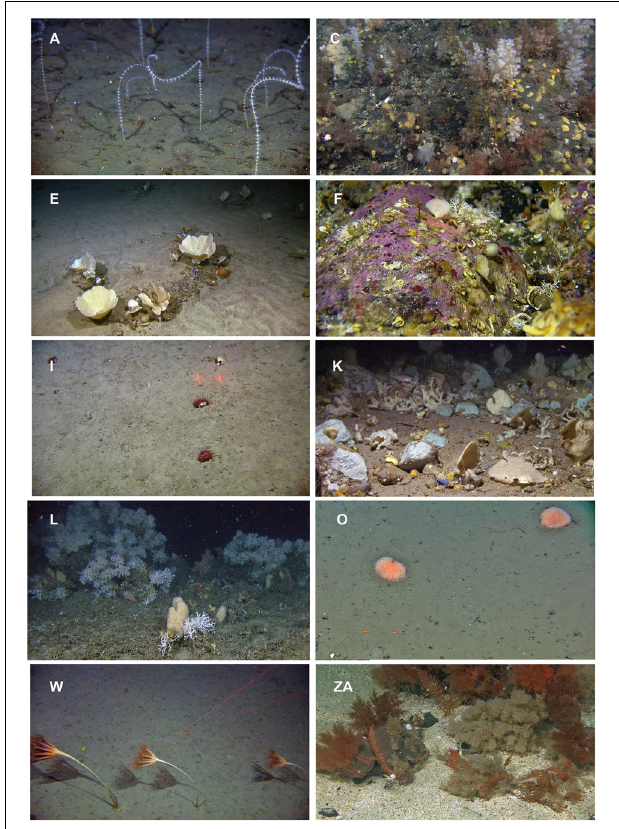
FIGURE 6 | Examples of 10 contrasting biotopes identified by a TWINSPAN analysis of the species data from the video analyses. The letters represent the biotope abbreviation corresponding to Table 2 . Arctic Intermediate Water Masses: (A) Soft bottom coral garden dominated by the pigtail coral ( Radicipes gracilis ) on the slope south west of Svalbard. (C) Encrusting sponges and tunicates and cauliflower corals on a gravelly bottom. (E) Sponge garden on sandy bottom dominated by Phakellia sp. and Axinella sp. Atlantic Water: (F) Hard substrates dominated by encrusting red algae in strandflat areas. (I) Mixed sediments dominated by cup corals ( Flabellum macandrewi ). (K) Sponge garden with a variety of axinellid sponges on mixed bottom. (L) Cold water coral reef ( Lophelia pertusa ) in the south western part of the study area. The same biotope complex is also represented by soft bottom sponge aggregations dominated by Geodidae sponges. (O) Muddy bottom on the shelf in central parts of the study area dominated by the anemone Liponema multicornis . Norwegian Sea Deep Water: (W) Sandy substrate on the lower slope dominated by the sea pen Umbellula encrinus . Arctic Water: (ZA) Shallow, sandy, gravelly bank dominated by the holothurian Cucumaria frondosa , the hydrozoan Thuiaria obsoleta , and the bryozoan Eucratea loricata